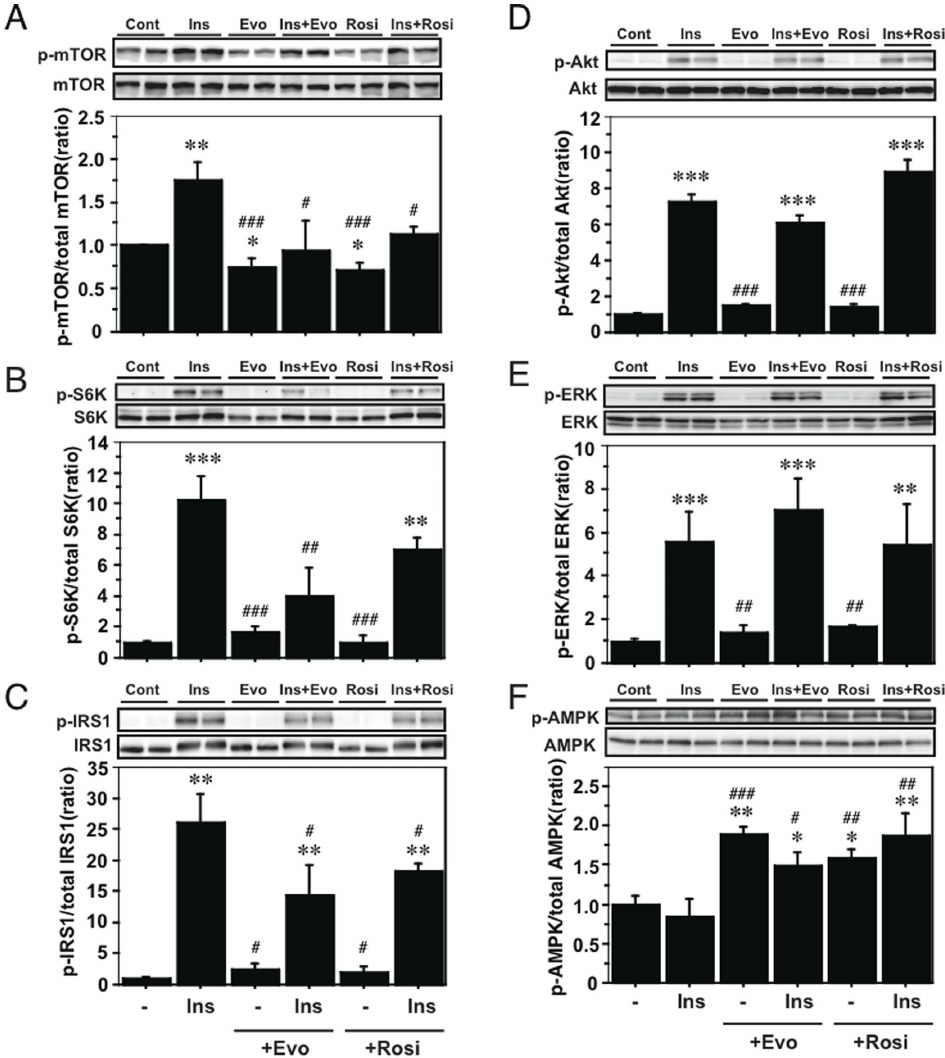
Figure 8. Effect of evodiamine and rosiglitazone on the mTOR-S6K signaling in adipocytes with or without insulin stimulation. After 3T3-L1 pre-adipocytes were differentiated into mature adipocytes, the cells were maintained in DMEM for 4 h and then stimulated by 20 nM insulin, 20 m M evodiamine or 20 m M rosiglitazone alone, or in combination with insulin and evodiamine or rosiglitazone for 30 min. The cell lysates (15– 30 m g protein) were analyzed for phosphorylation of mTOR Ser2448, S6K Thr389, IRS1 Ser636/639, Akt Ser473, ERK Thr202/Tyr204 and AMPK Thr172 by Western blot analysis. Phosphorylation levels were normalized to the total level of each protein. Data are expressed as mean 6 SEM ( n =3–5). * p , 0.05, ** p , 0.01, *** p , 0.001 vs. control group without stimulation. # p , 0.05, ## p , 0.01, ### p , 0.001 vs. insulin